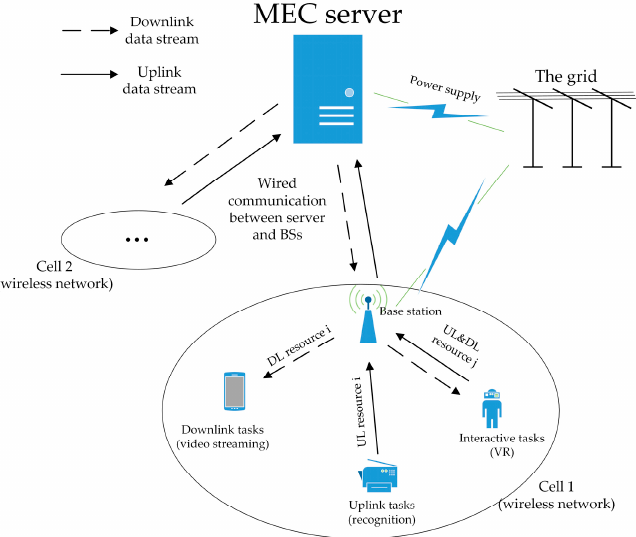
Figure 1. Optimization problem scenarios.